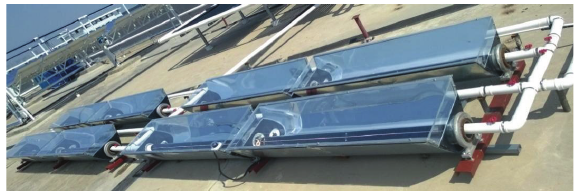
Figure 8: Experimental system photo.